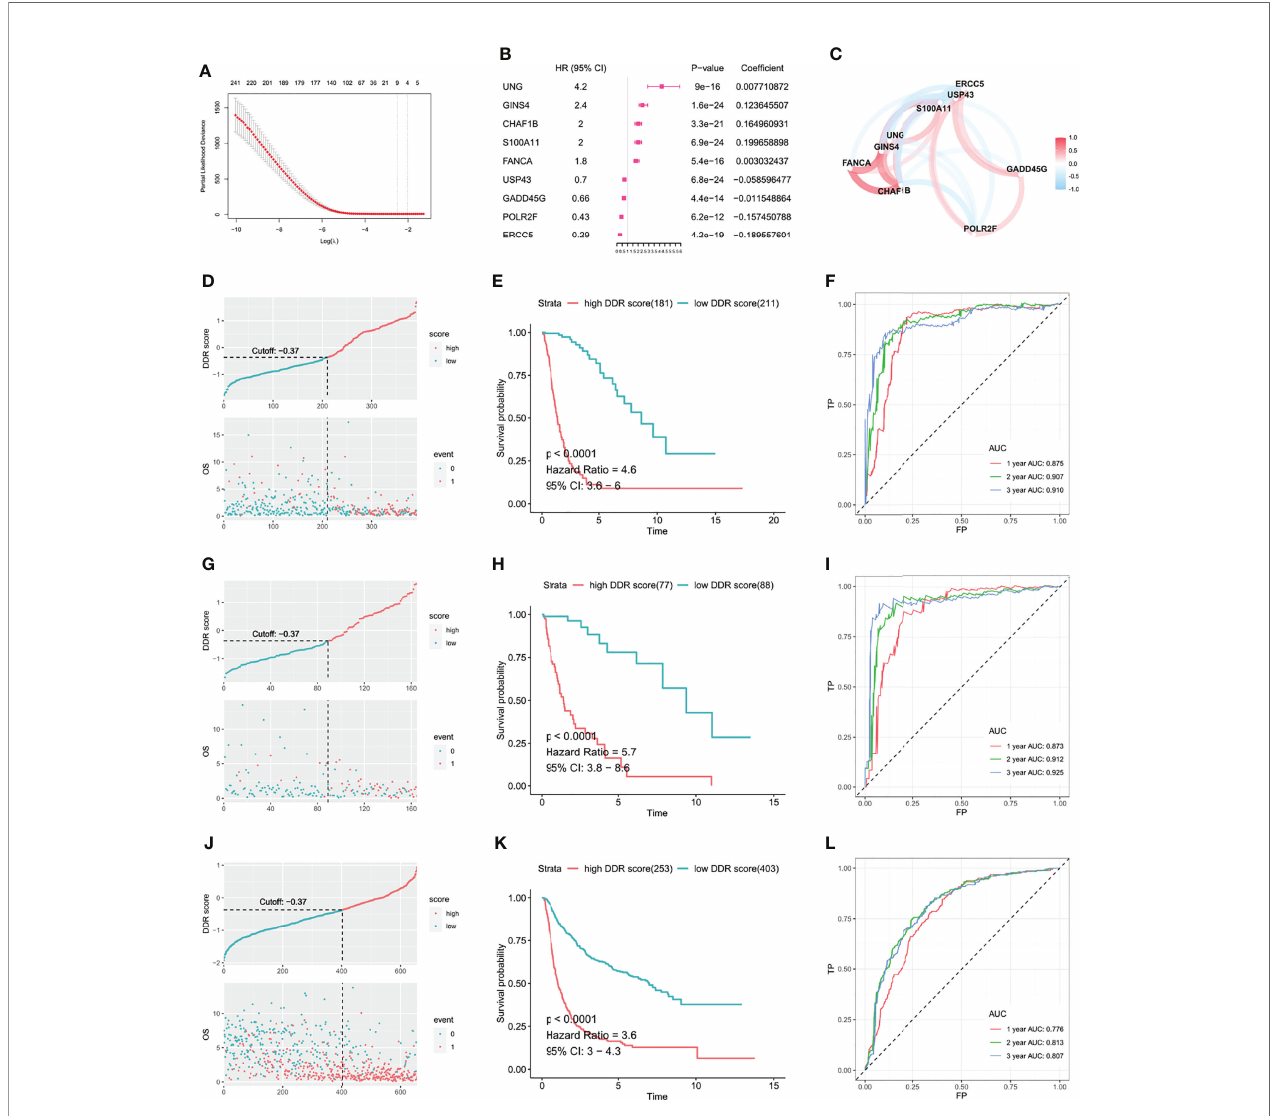
FIGURE 2 | DDR score was established to investigate the predictive value in glioma. (A) DDR-related DEGs were further selected by LASSO cox regression to generate a risk model. (B) Coef fi cients and HR calculated by LASSO cox regression of nine variates. (C) The mutual relationship of the expression level of the nine genes. The scatter plot and Kaplan-Meier curves demonstrated that the high DDR score correlated with an unfavorable outcome in the TCGA training cohort (D, E) , TCGA validation cohort (G, H) , and CGGA validation cohort (J, K) . ROC curves suggested that the DDR score substantially predicted the prognosis in the TCGA training cohort (F) , TCGA validation cohort (I) , and CGGA validation cohort (L)